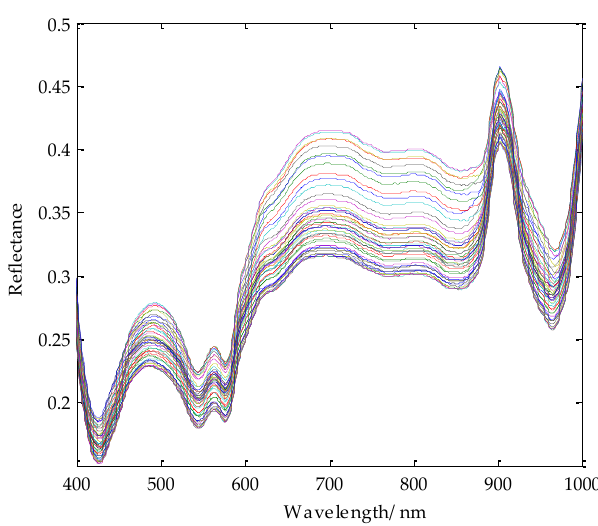
Figure 3. Raw spectra of all the pork meat samples from the first day to the fifteenth day; the spectra are the averaged value of the ROI.